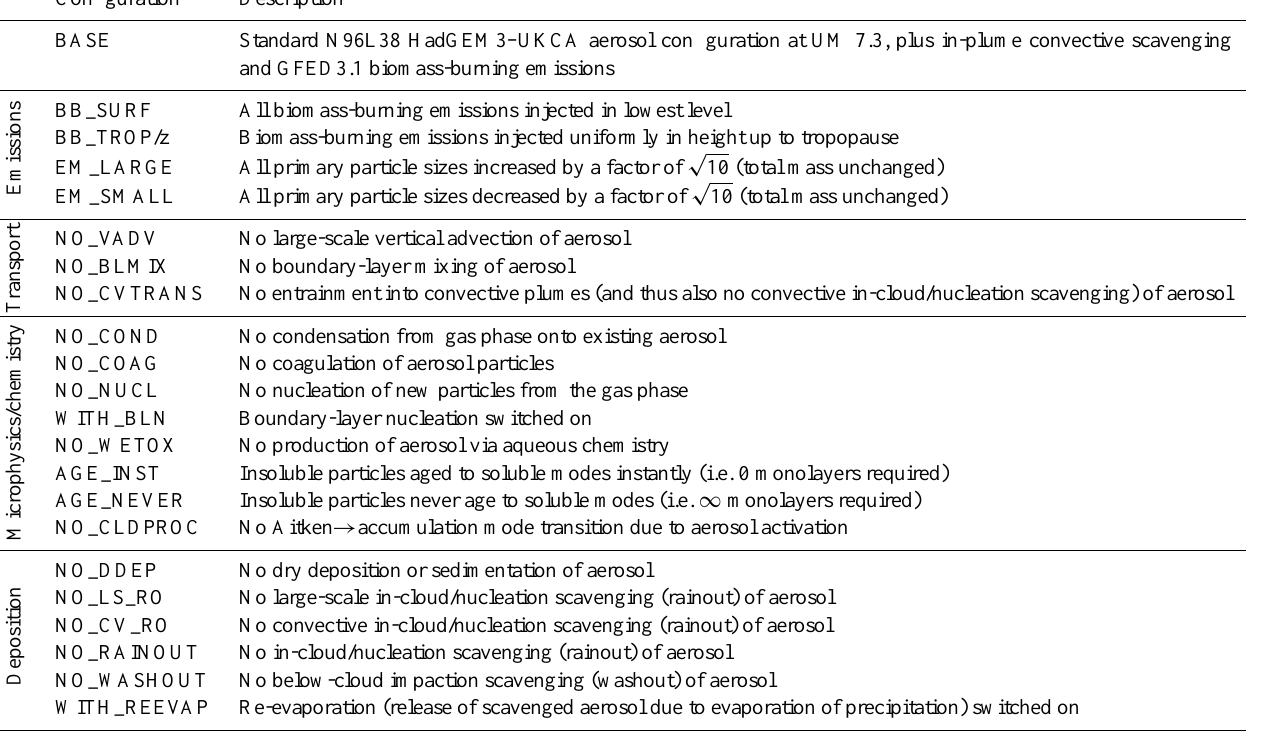
Table 2. Configurations of HadGEM3–UKCA used for process sensitivity-test simulations.